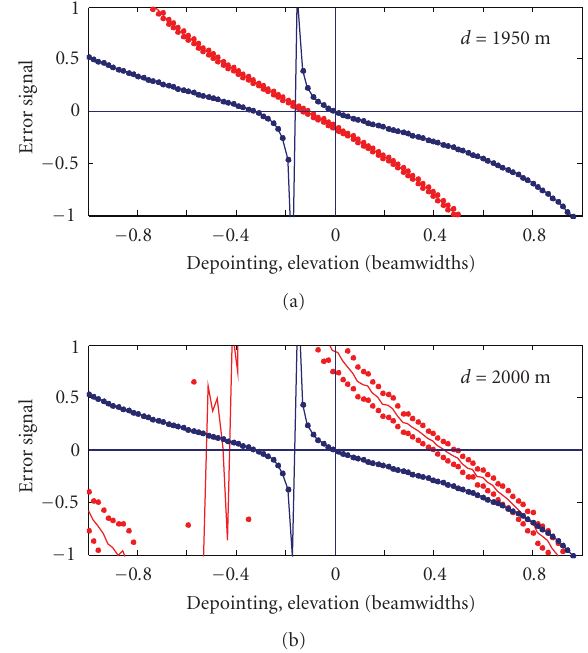
Figure 9: Error function, as a function of elevation error, for the standard and crossfeed monopulse over a rough sea, in case of ideal comparator. (a) Blue: crossfeed; solid line: average; bullets: standard deviation limits around the average values. (b) Red: standard feed; solid line: average; bullets: standard deviation limits around the average